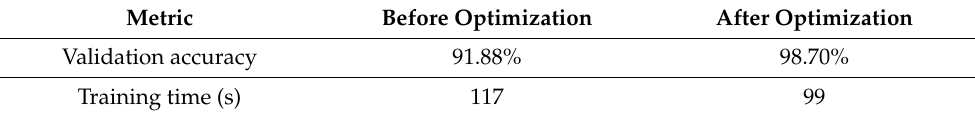
Table 6. Comparison between the performance of the scratched model before and after optimization. Metric Before Optimization After Optimization Validation accuracy 91.88% 98.70% Training time (s) 117 99